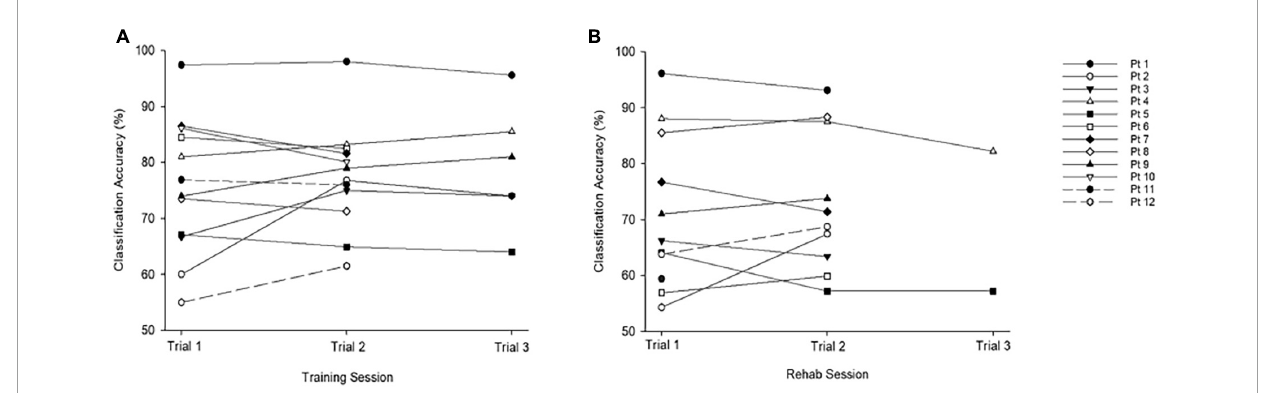
FIGURE2 Classification accuracies across training and rehabilitation sessions. (A) Average accuracy across all training trials was M = 76.91%, SD = 10.78, range = 55–96%. (B) Average accuracy across all rehabilitation trials was M = 70.85%, SD = 12.21, range = 57–88%. The chance level is 50%.